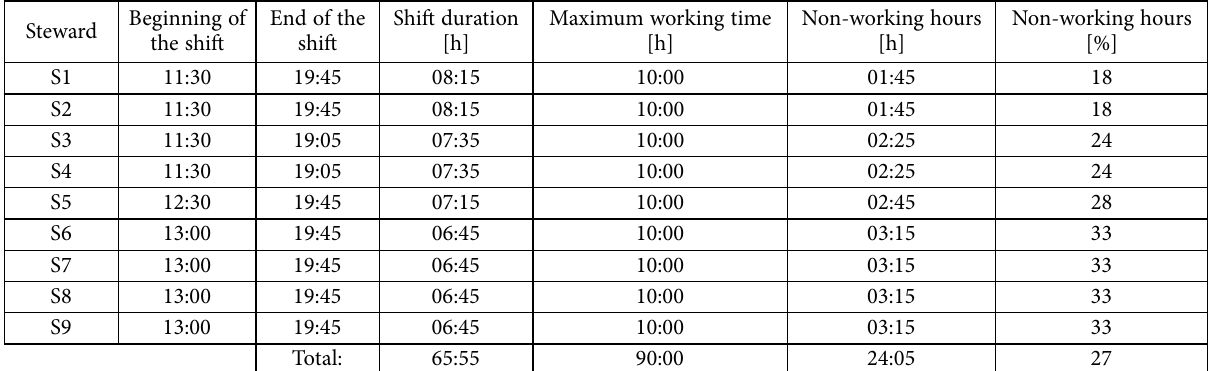
Table 7. Numerical results for instance of 4